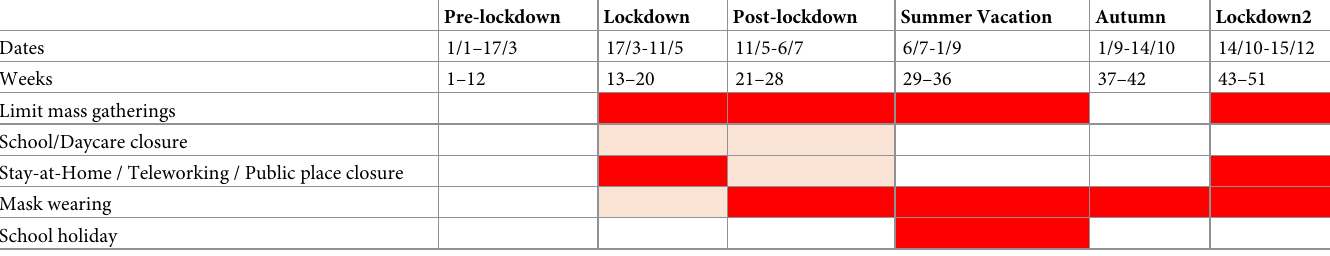
Table 1. Time periods defined according to the adoption of mitigation measures against COVID-19 and summer